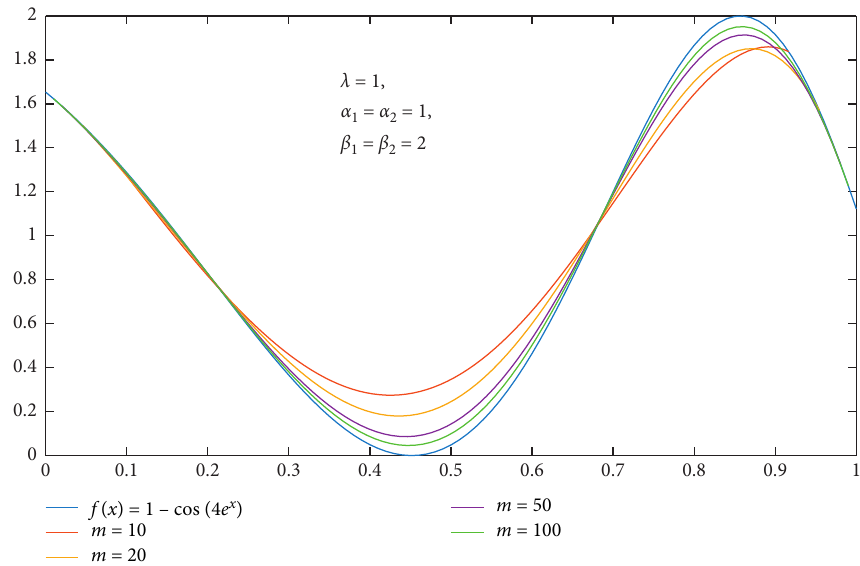
( f,x ) to f ( x ) with respect to m values. m, − 1